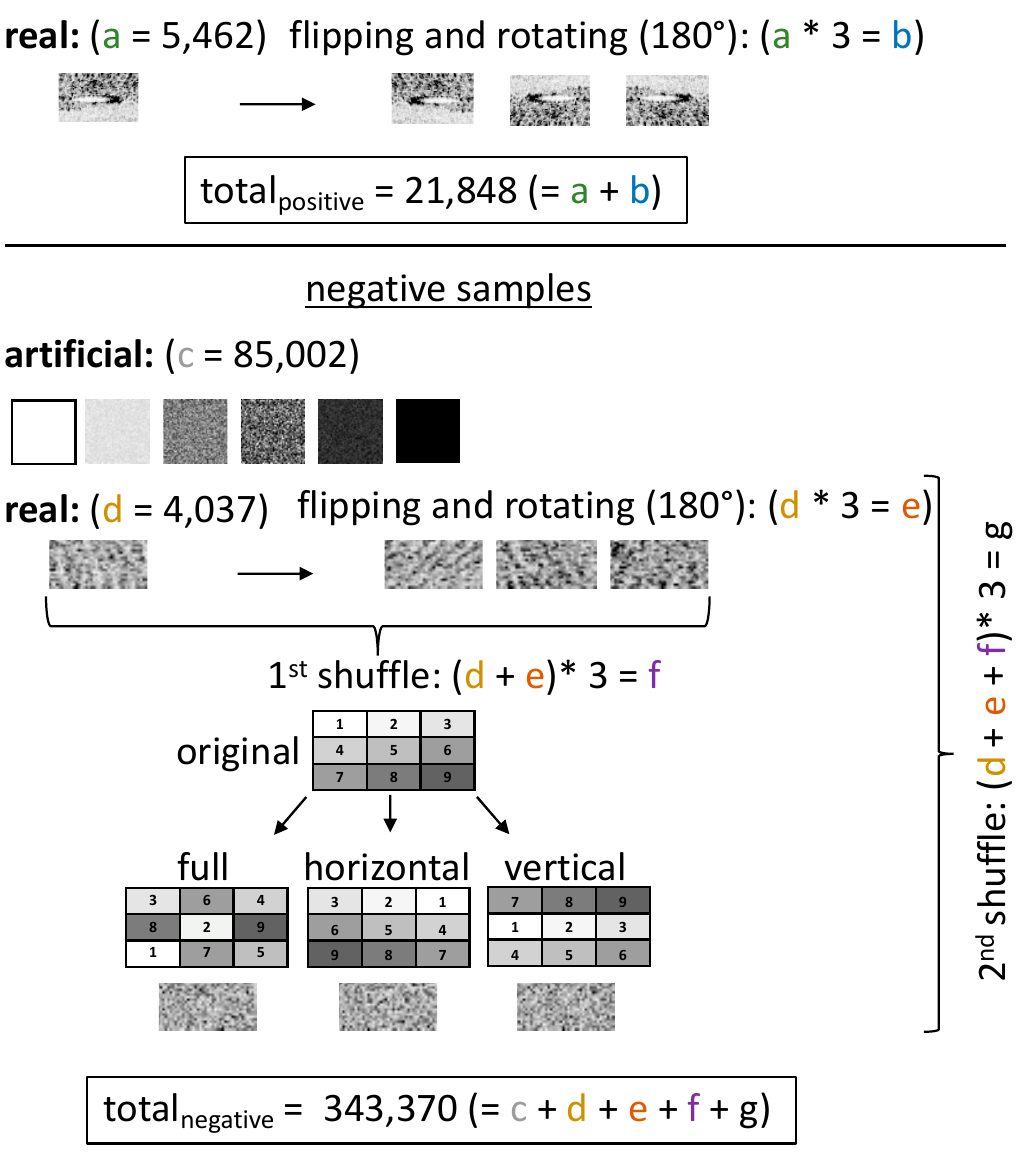
Figure 2. Schematic workflow of the multiplication and final numbers of positive and negative training samples. Dark colors of the SSS mosaic represent high backscatter and bright colors represent low backscatter values.